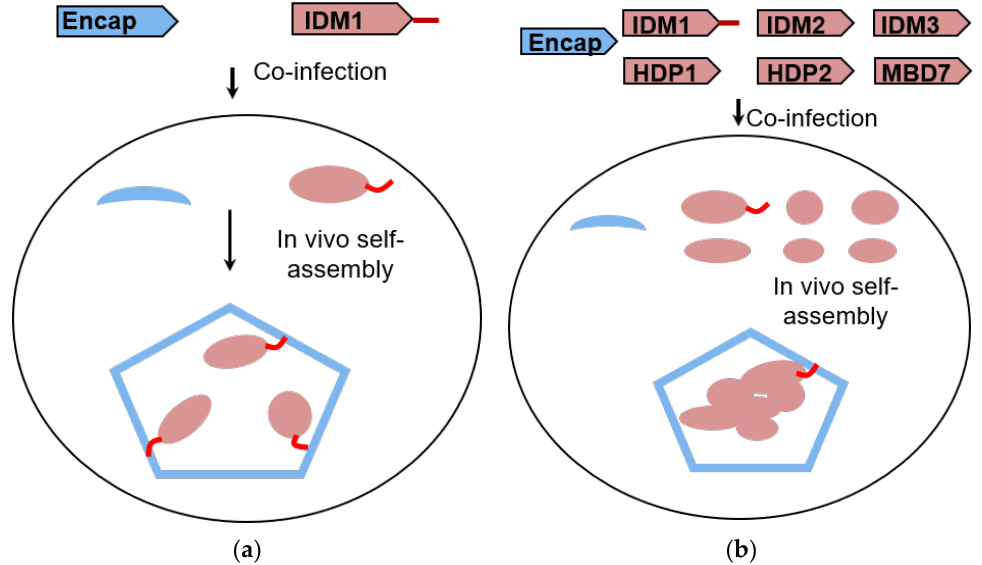
Figure 1. Schematic representation of heterologous cargo-loaded encapsulin expression in insect cells. Diagrams of in vivo encapsulin assembly resulted from the coexpression of Encap and cargo proteins in the baculovirus expression system with IDM1 as cargo alone ( a ) and the IDM holo complex as cargo ( b ).